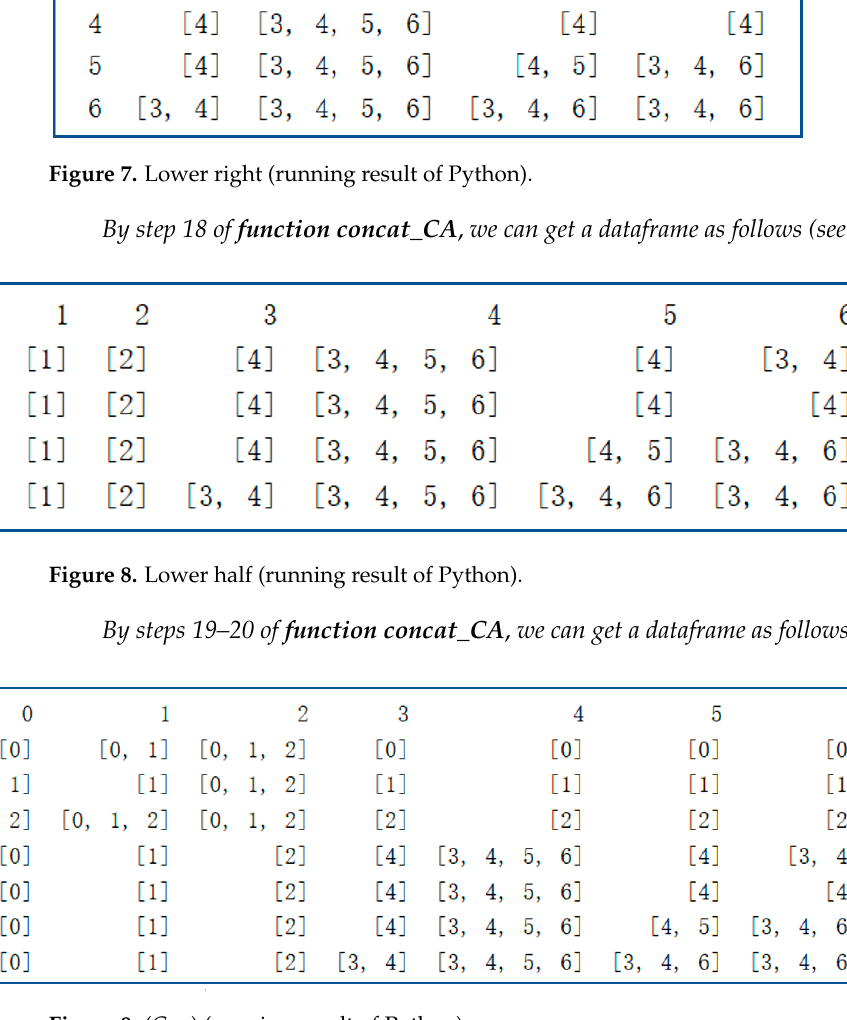
Figure 10. New top left (running result of Python). Figure 11. New lower right (running result of Python). If the Boolean expression in step 31 evaluates True , then the program executes recursive function concat_CA ( CA1 , CA2 , n ) until it breaks out of the while loop. Now that CA1 = ( C 1 , ▴ 1 ) , CA2 = ( C 2 , ▴ 2 ) n = 2 , we get a CA supergroup as follows(see Figure 12): Figure 12. ( P , ▪ ) (running result of Python).